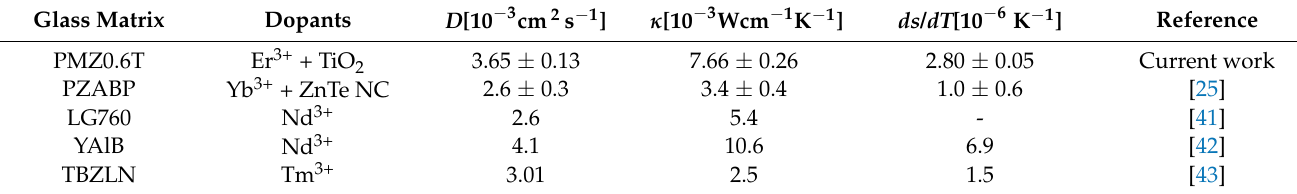
Table 2. Thermo-optical properties of some known